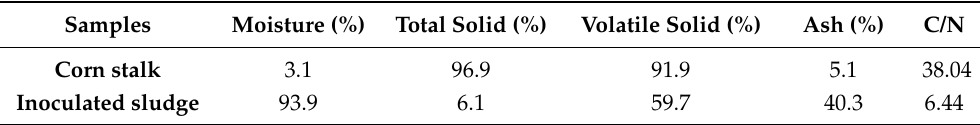
Table 2. Basic properties of corn stalks and inoculated